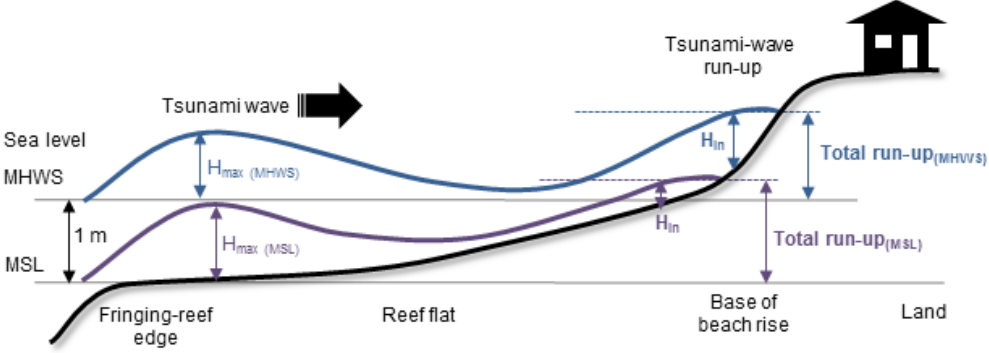
Figure 4. Schematic depiction of model sea levels used in the tsunami simulations and terminology used to quantify tsunami-wave inundation. The horizontal and vertical dimensions are not to